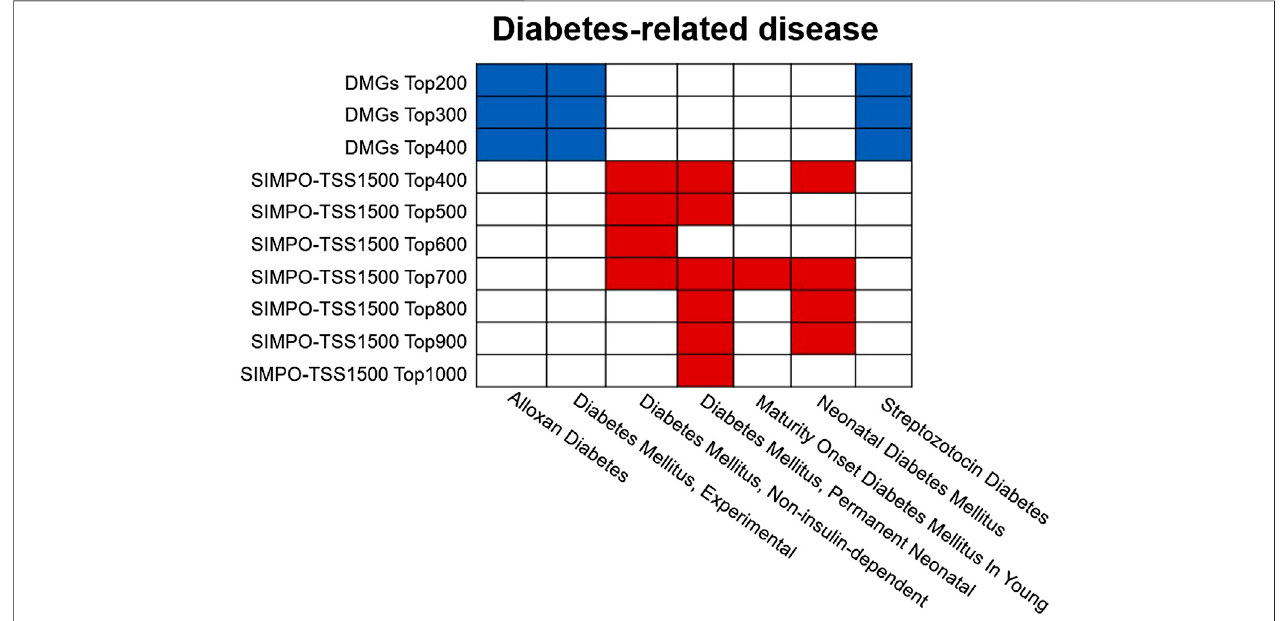
FIGURE 6 | The diabetes-related disease enrichment of DMGs- and SIMPO-TSS1500-predicted top N gene sets. Enrichment analysis was obtained from the Enrichr database (http://amp.pharm.mssm.edu/Enrichr/). The diabetes-related diseases include alloxan diabetes, experimental diabetes mellitus, non-insulin- dependent diabetes mellitus, permanent neonatal diabetes mellitus, maturity onset diabetes mellitus in young, neonatal diabetes mellitus, and streptozotocin diabetes. ThebluesquaresindicatethattheDMGs-predictedtopNgenesetissigni fi cantlyassociatedwiththecorrespondingdiabetes-associateddisease;theredsquares indicate that the SIMPO-TSS1500-predicted top N gene set is signi fi cantly associated with the corresponding diabetes-related disease.